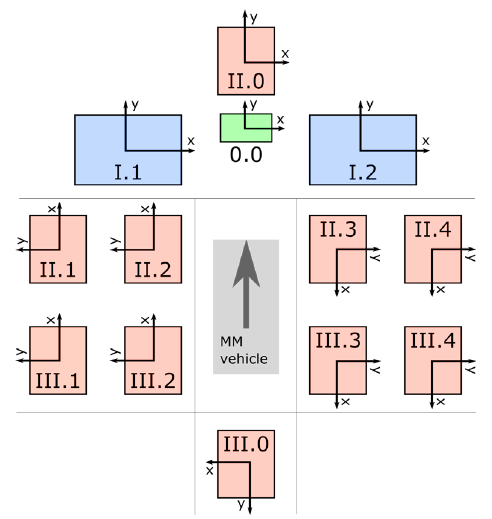
Figure 3. Outline of our camera setup showing the definitions of image coordinate systems for calibration and processing